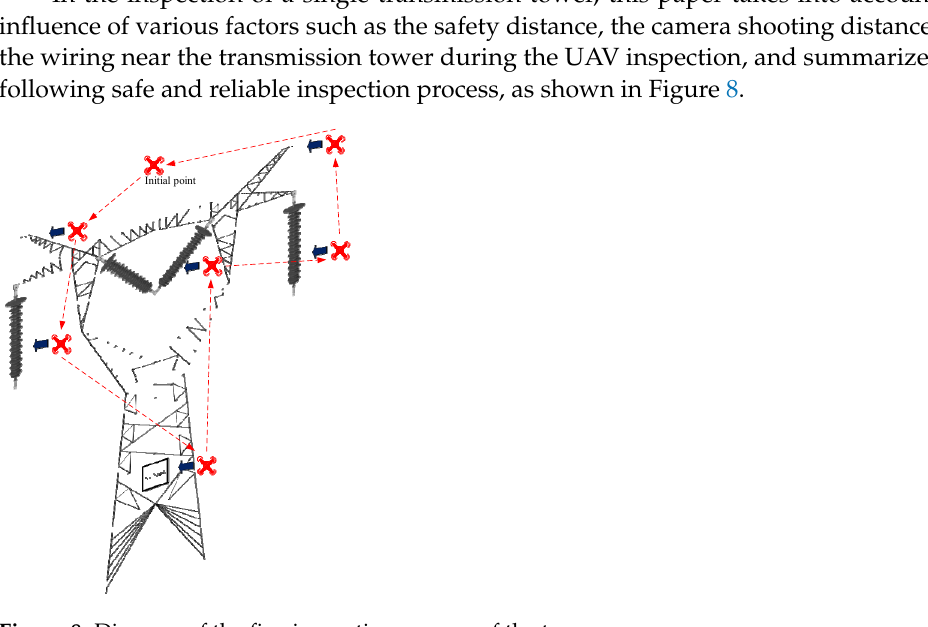
Figure 8. Diagram of the fine inspection process of the tower.